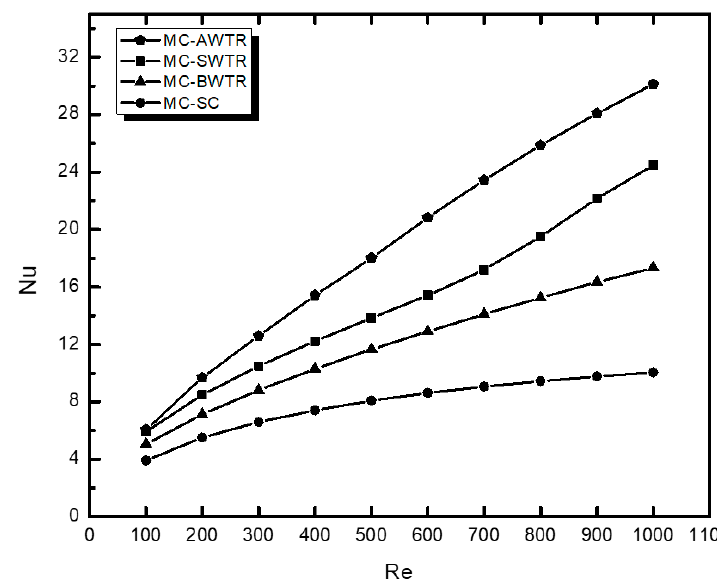
Figure 8. Comparison of Nusselt number for different wall configurations MCHS.